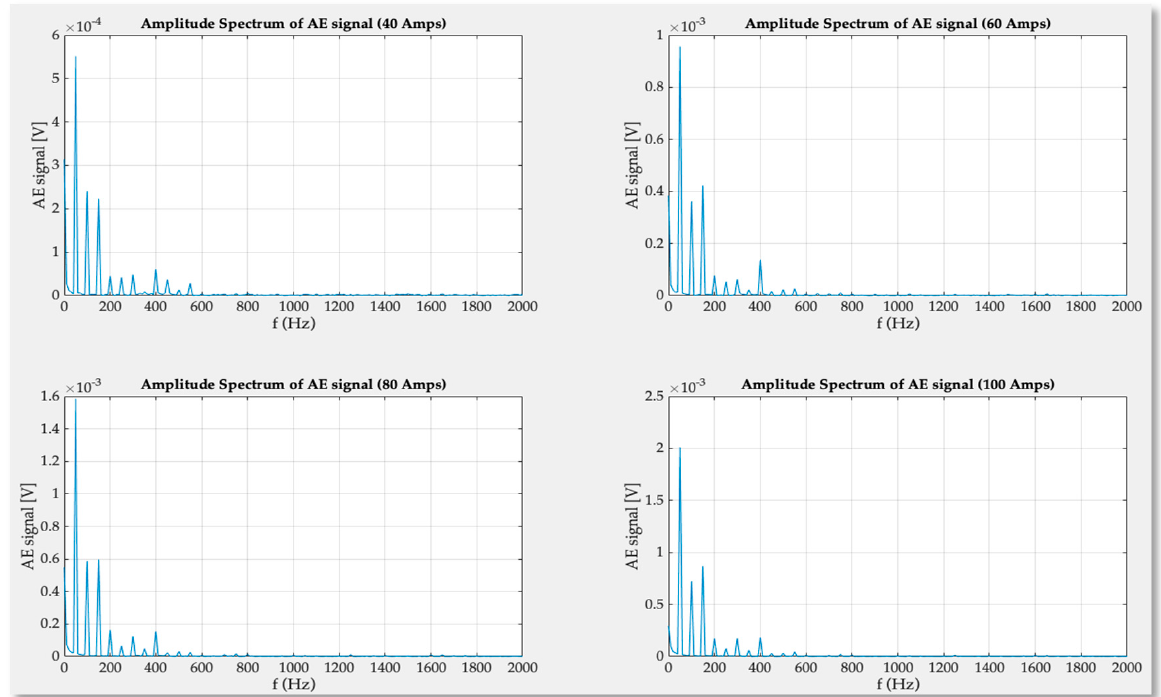
Figure 13. Narrowed frequency spectrum of signal recorded for 40, 60, 80 and 100 amperes anode-cathode rectified current.